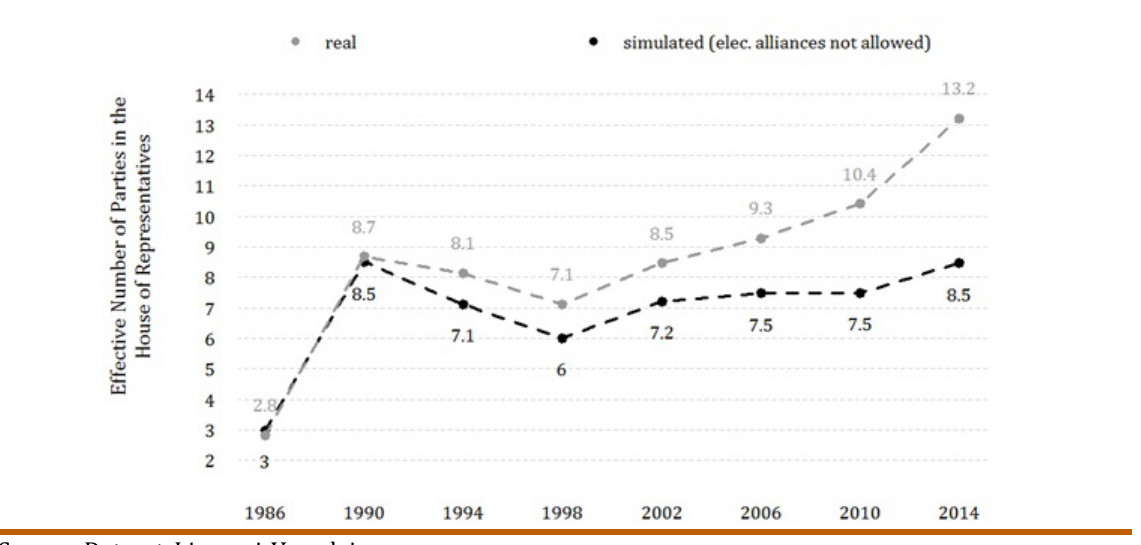
Graph 7. House of Representatives: actual party fragmentation versus party fragmenta- tion simulated with electoral alliances not